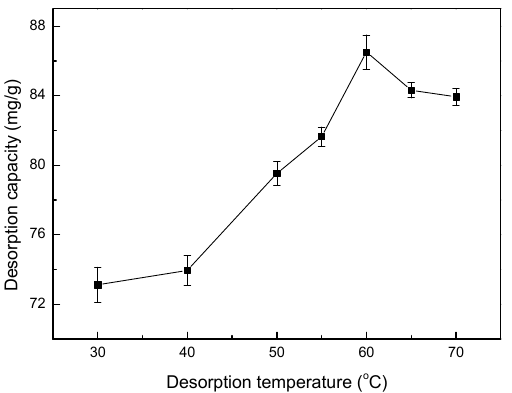
Figure 15. Effect of temperature on desorption capacity of LMT. Co(II) ‐ loaded LMT nanocomposite: 0.1000 g; nitric acid (HNO 3 ) concentration: 0.5 mol/L; and time: 55 min.